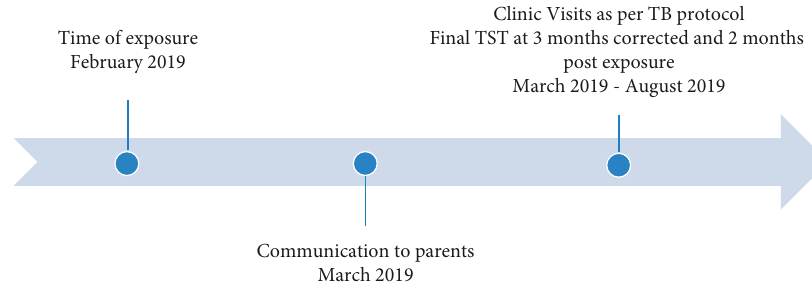
Figure 1: Timeline of exposure through clinical follow-up.